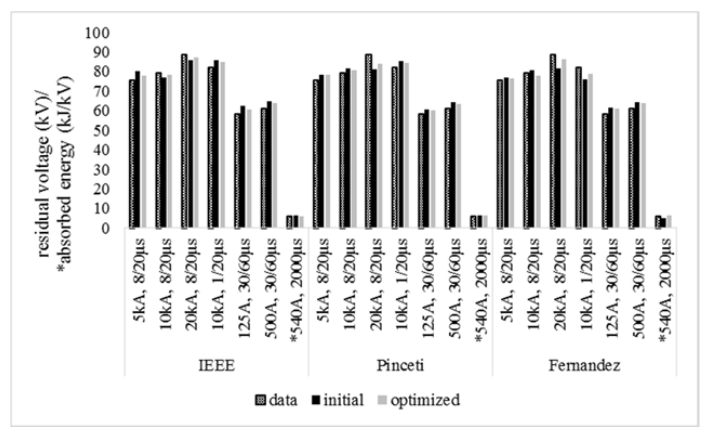
Figure 10. Residual voltage (in kV) and dissipated energy (in kJ/kV) for the three examined models (case 3) (the symbol * corresponds to the absorbed energy by the arresters). Table 3. Comparison of the harmony search method, downhill simplex method [15], Powell method [16] and genetic algorithm [17]: relative error (%) between simulation results and manufacturer’s data.